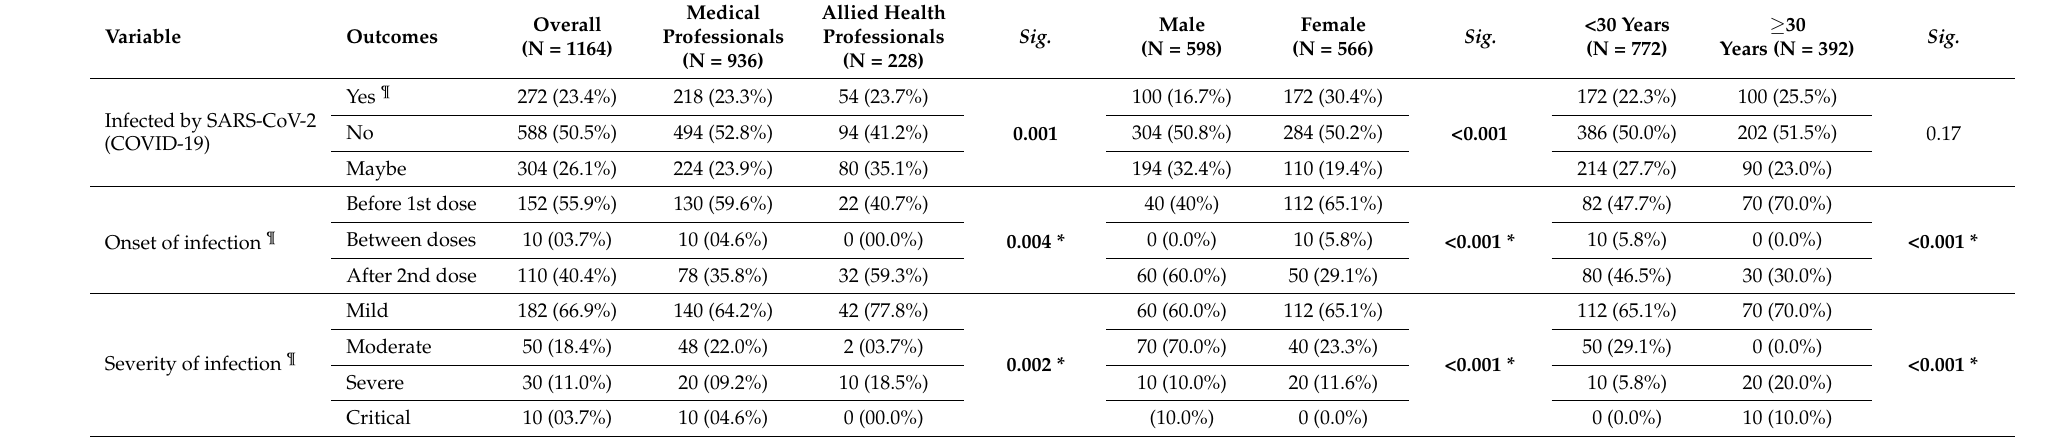
Table 2. COVID-19-related history of the respondents.